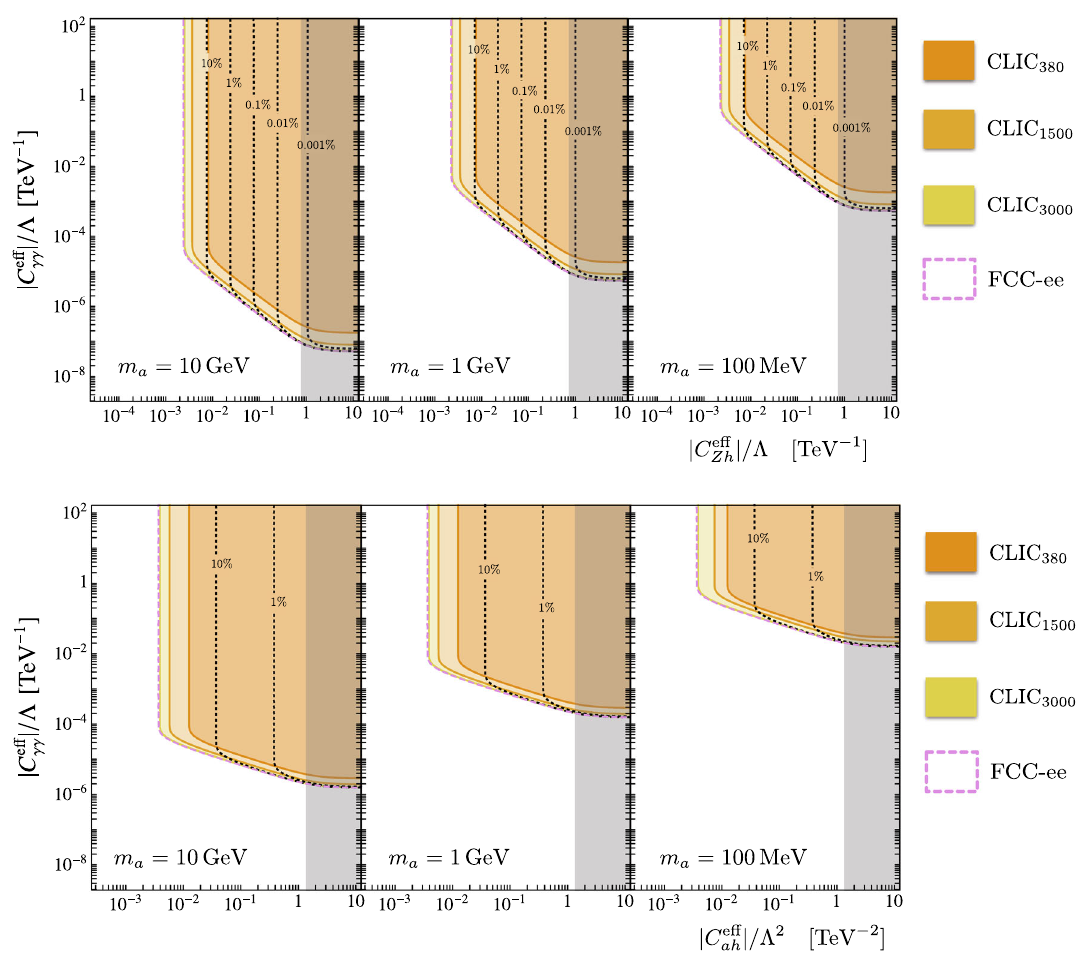
Fig. 10 Parameter regions which can be probed in the decay h → Za with a → γγ (upper row) and h → aa with a → γγ (lower row) at future e + e − colliders. The grey shaded area is excluded by LHC Higgs